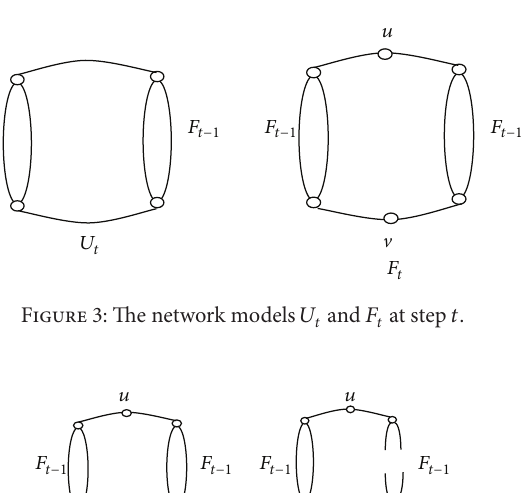
And the shape of the spanning forests with two compo- nents such as 𝑢 and V belongs to distinct components of 𝐹 𝑡 that have five cases; see Figure